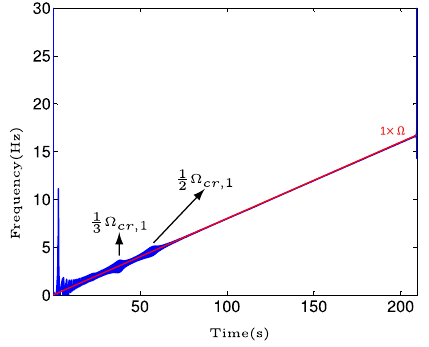
Figure 13. Time–frequency representations of the vertical transient response of the system with a small crack, ( µ = 0.2 ) , using HHT based on improved EMD, and the crack is modeled using the proposed breathing function in this